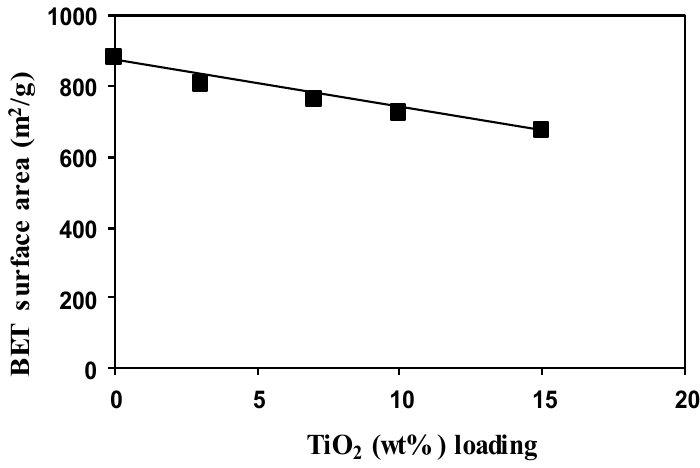
2 /HY from bottom to top, respectively.